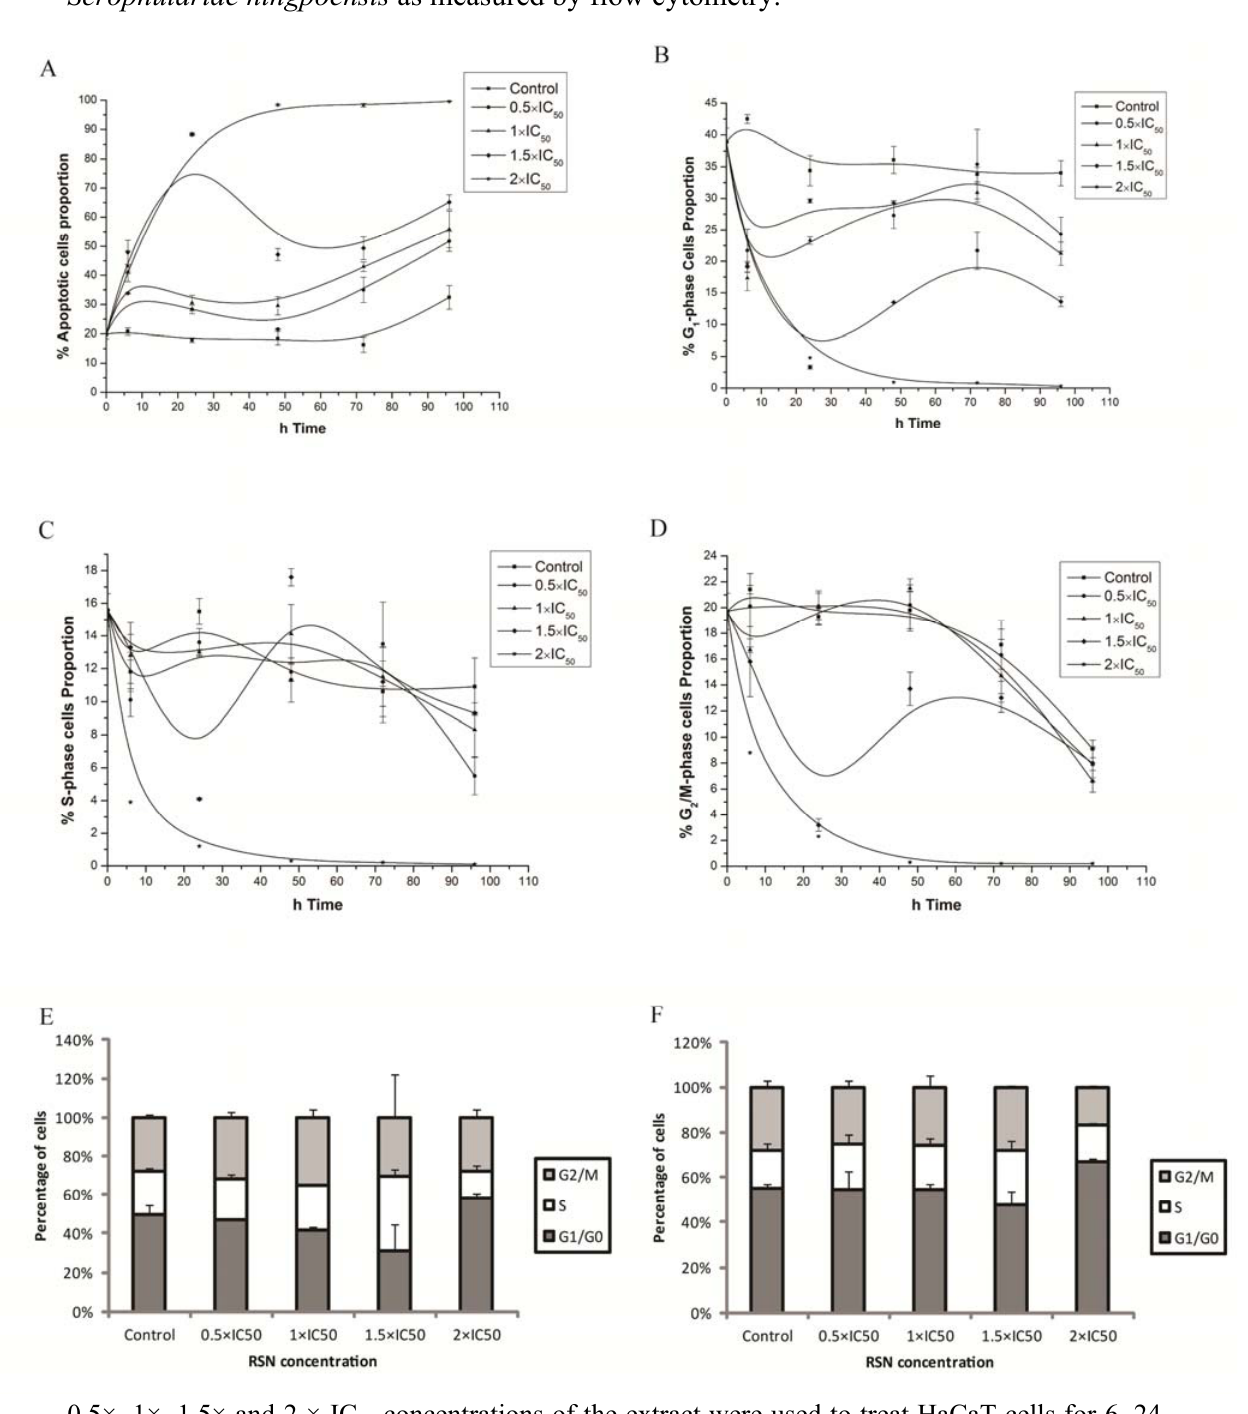
Figure 5. Apoptosis and cell cycle distribution of HaCaT cells treated with Radix Scrophulariae ningpoensis as measured by flow